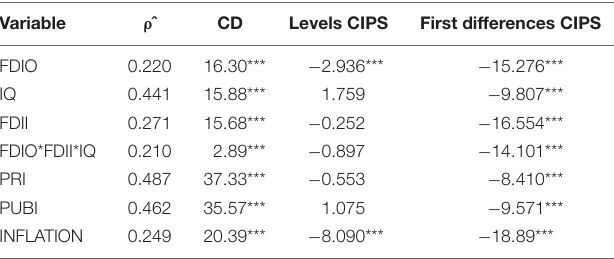
TABLE 2 | CD test and second-generation panel unit root.